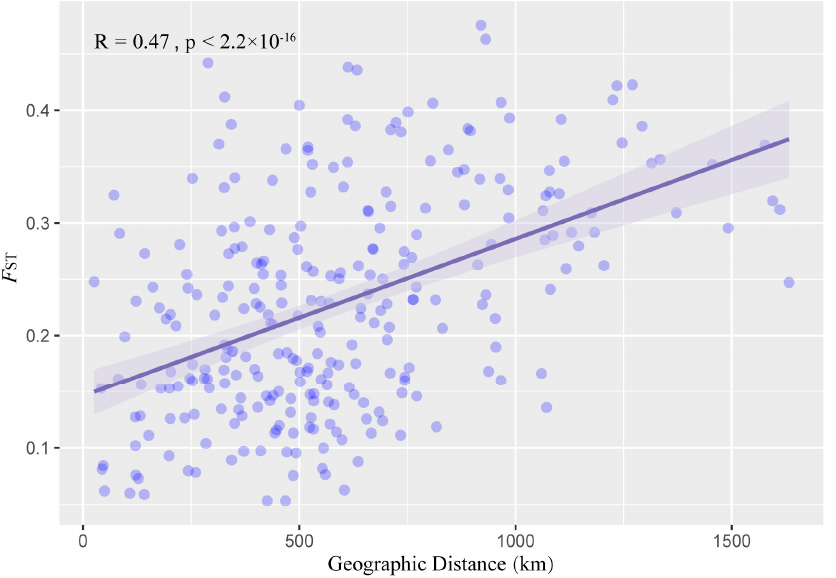
Figure 7. Relationships between the pairwise genetic distance ( F ST ) and geographic distance with blue bars and shading represent the 95% highest posterior